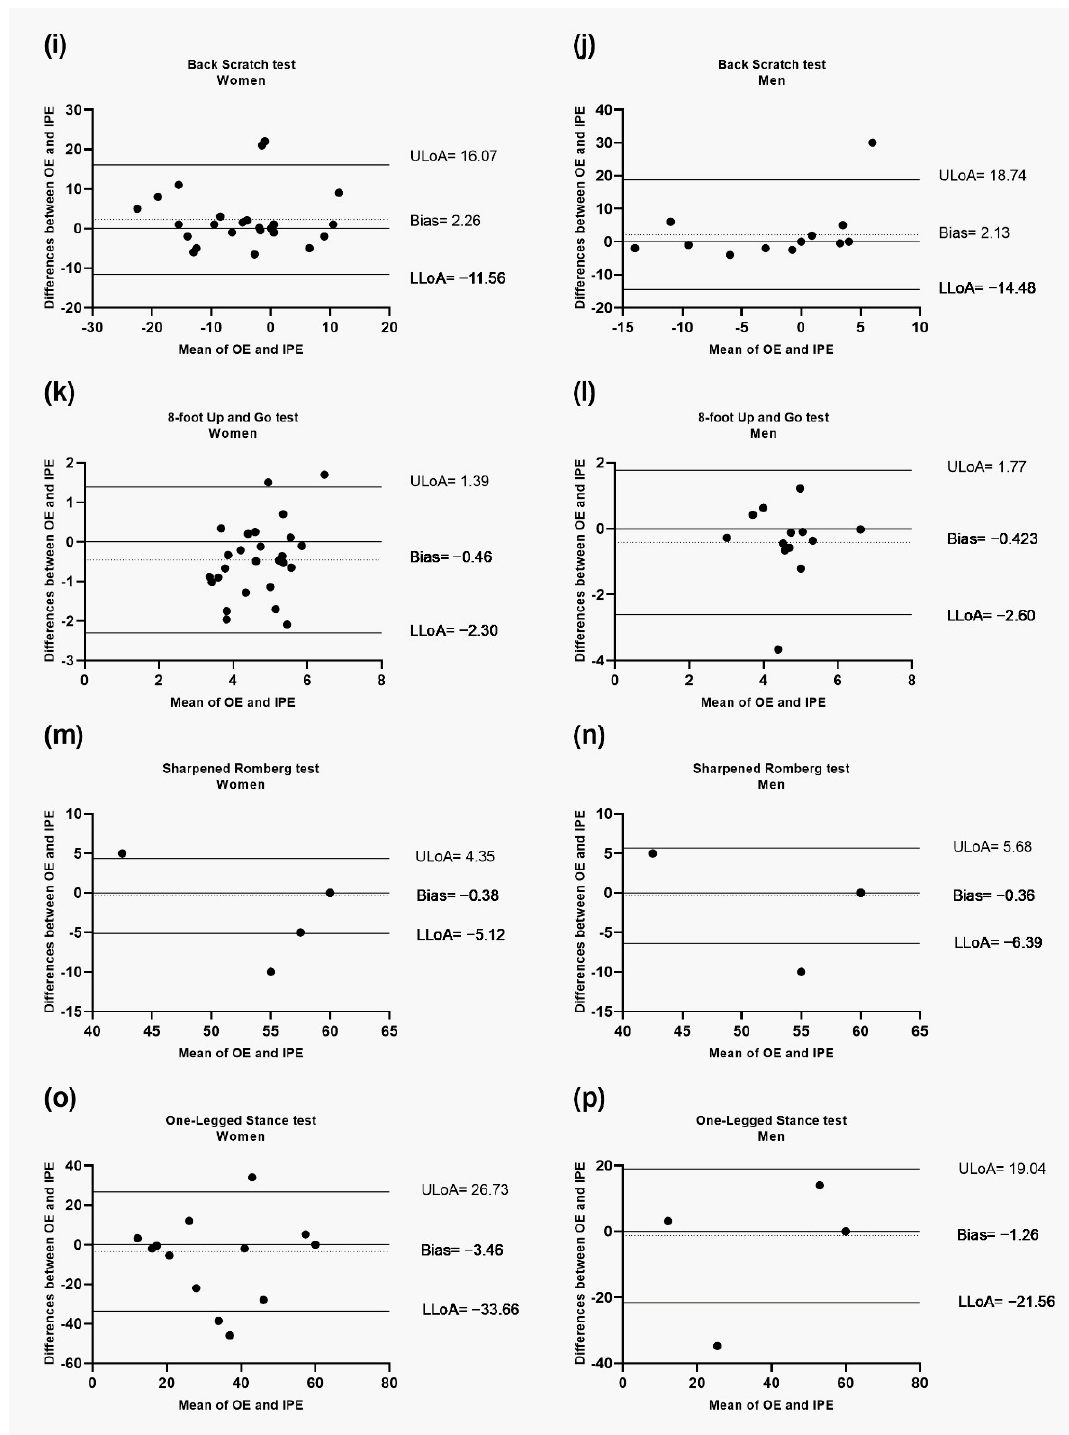
Figure 2. Bland-Altman plots for the difference between online evaluation and face-to-face evaluation of the SFT and the two balance test for participants divided by sex. ( i ) Back Scratch test for women; ( j ) Back Scratch test for men; ( k ) 8-foot Up and Go test for women; ( l ) 8-foot Up and Go test for men; ( m ) Sharpened Romberg test for women; ( n ) Sharpened Romberg test for men; ( o ) One-Legged Stance test for women; and ( p ) One-Legged Stance test for men. OE: online evaluation; IPE: face-to-face evaluation; ULoA: upper limit of agreement; LLoA: lower limit of agreement. The shaded areas represent the confidence interval limits for mean and agreement